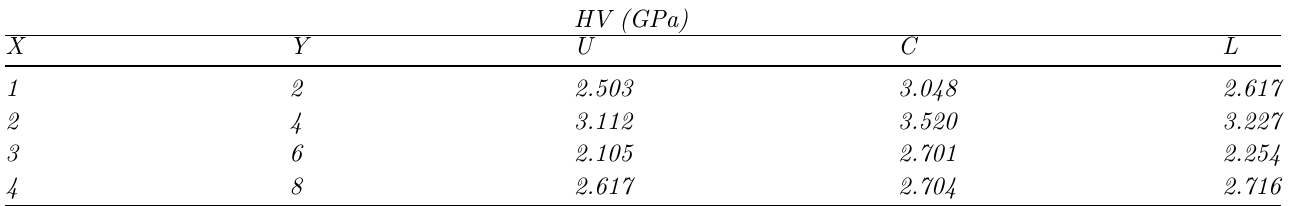
Table 1. Vickers micro hardness measured for the alloy at Upper (U), central (C) and lower (L) cross